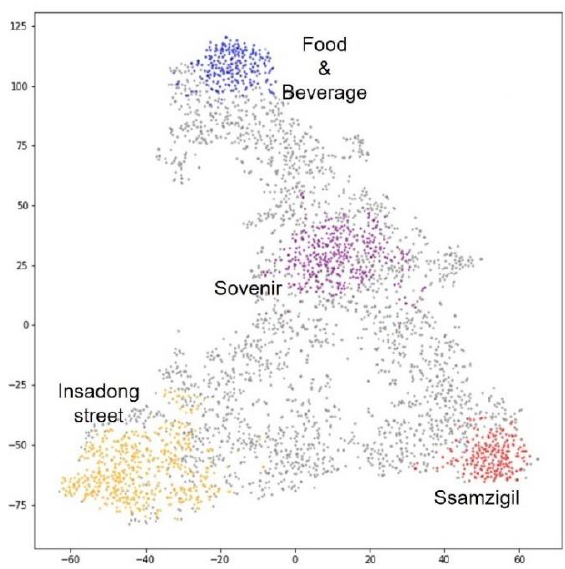
Figure 14. ROC curve of Insadong.